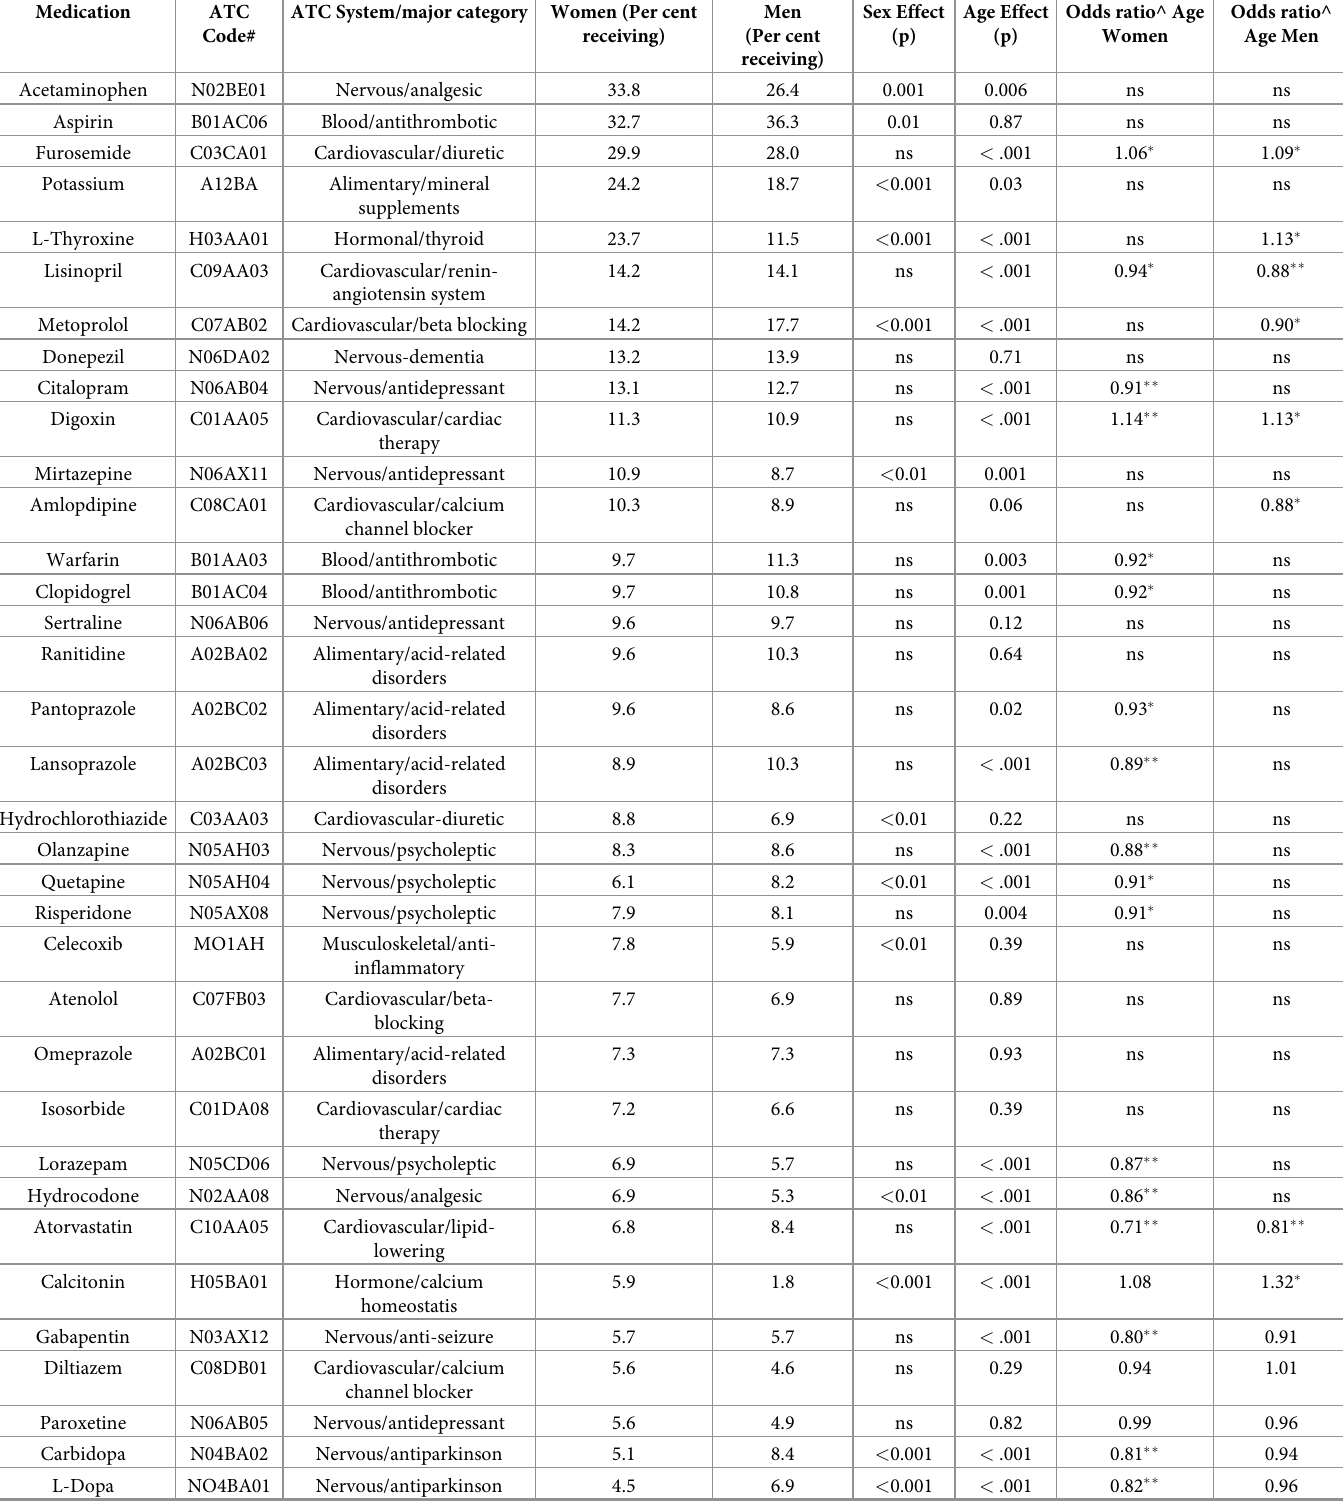
Table 2. Commonly prescribed chronic oral medications in older long-stay nursing home residents.